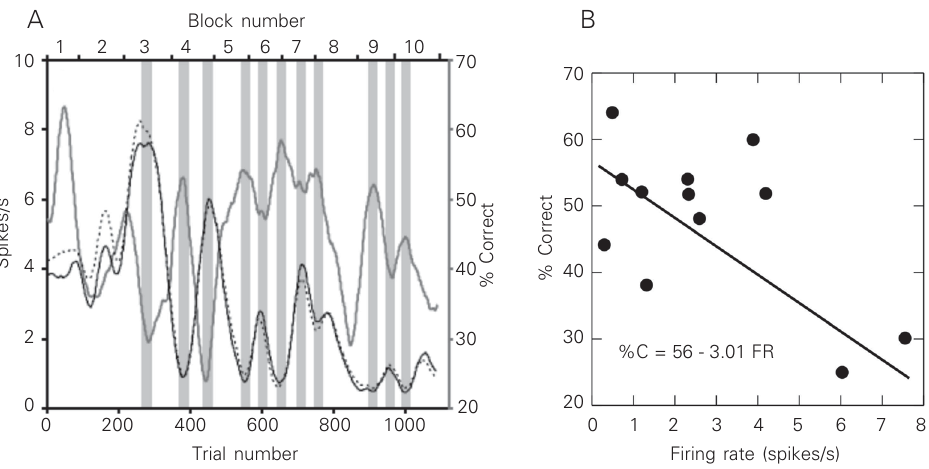
Figure 2. A , Activity of a perirhi- nal neuron whose firing rate shows an inverse correlation with the monkey’s behavioral performance. Conventions